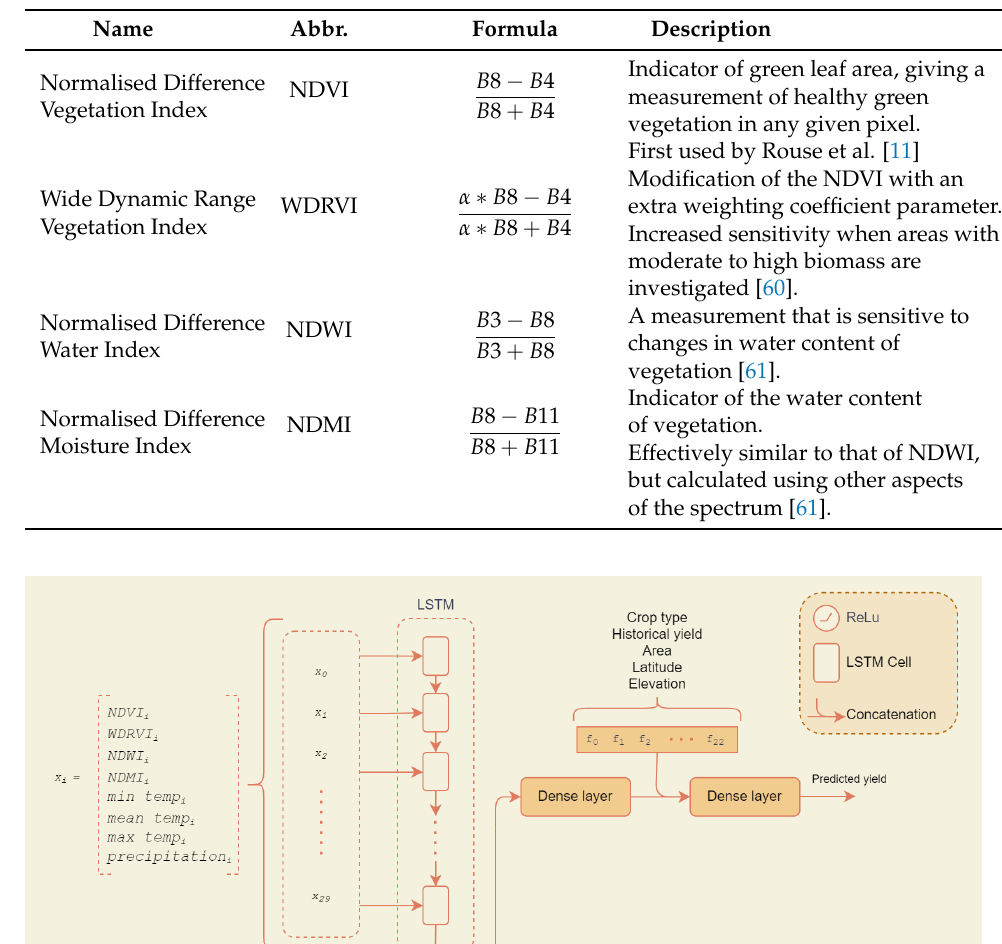
Table 3. Handcrafted features used as input. The bands (B) are Sentinel-2 specific.